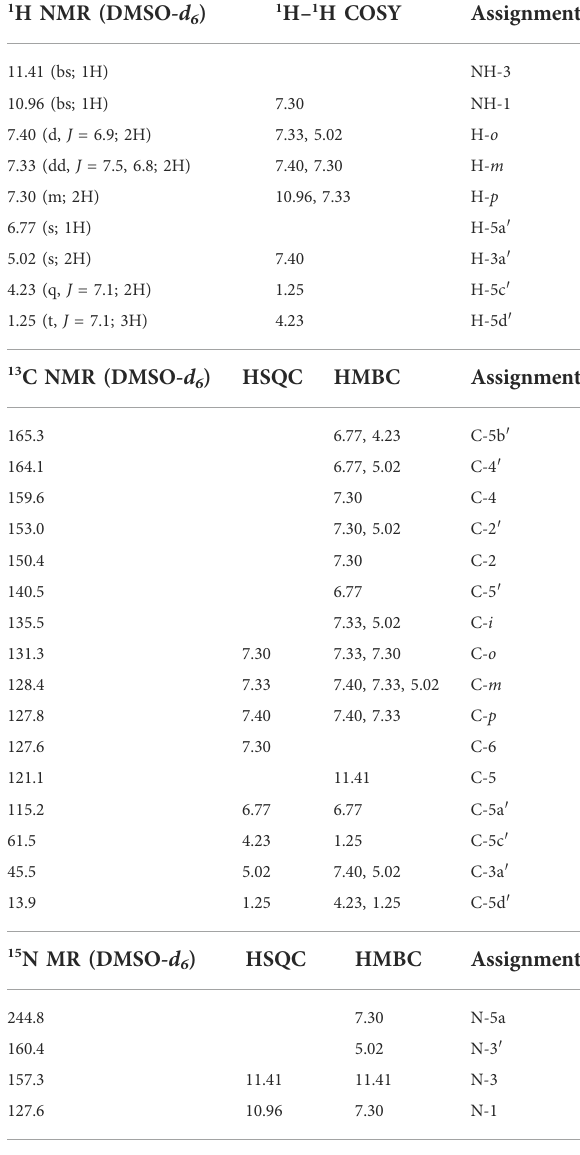
FIGURE 3 Distinctive carbons and hydrogens for compound 3d .